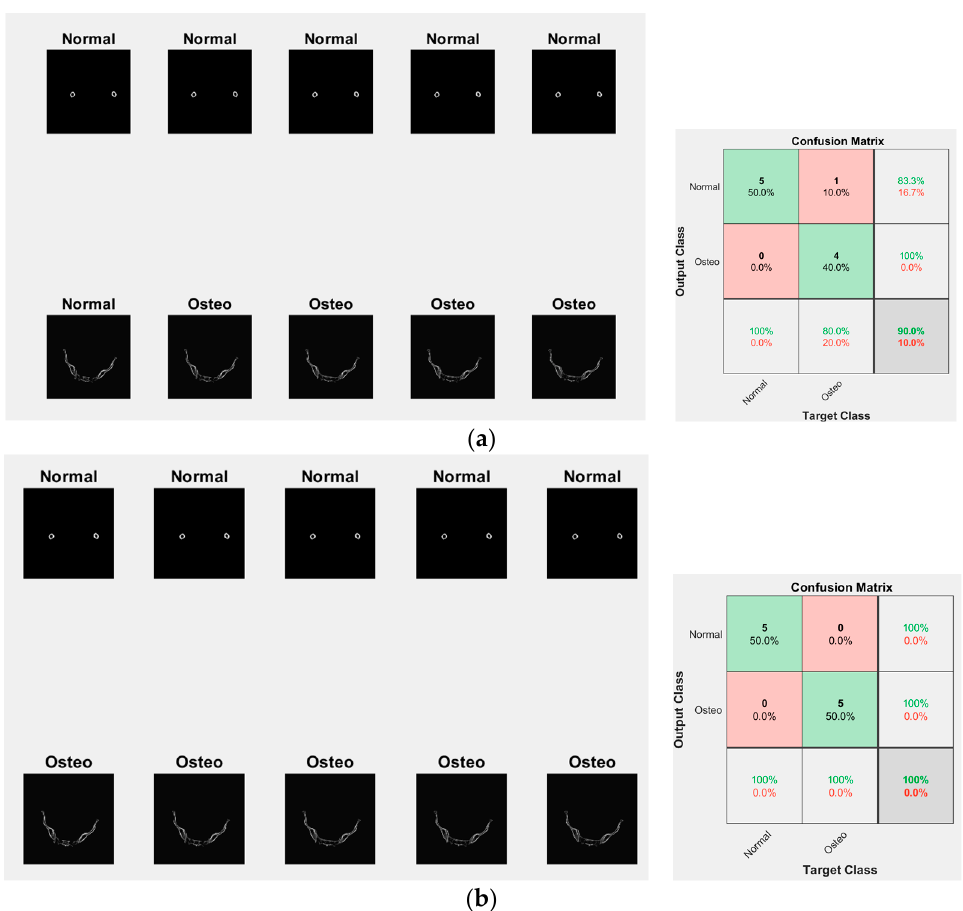
Figure 10. Classification results of ( a ) Scenario 1: CT scan only, and ( b ) CT scan and its attributes together with the confusion matrix, green color indicate the same class while red indicate different class.